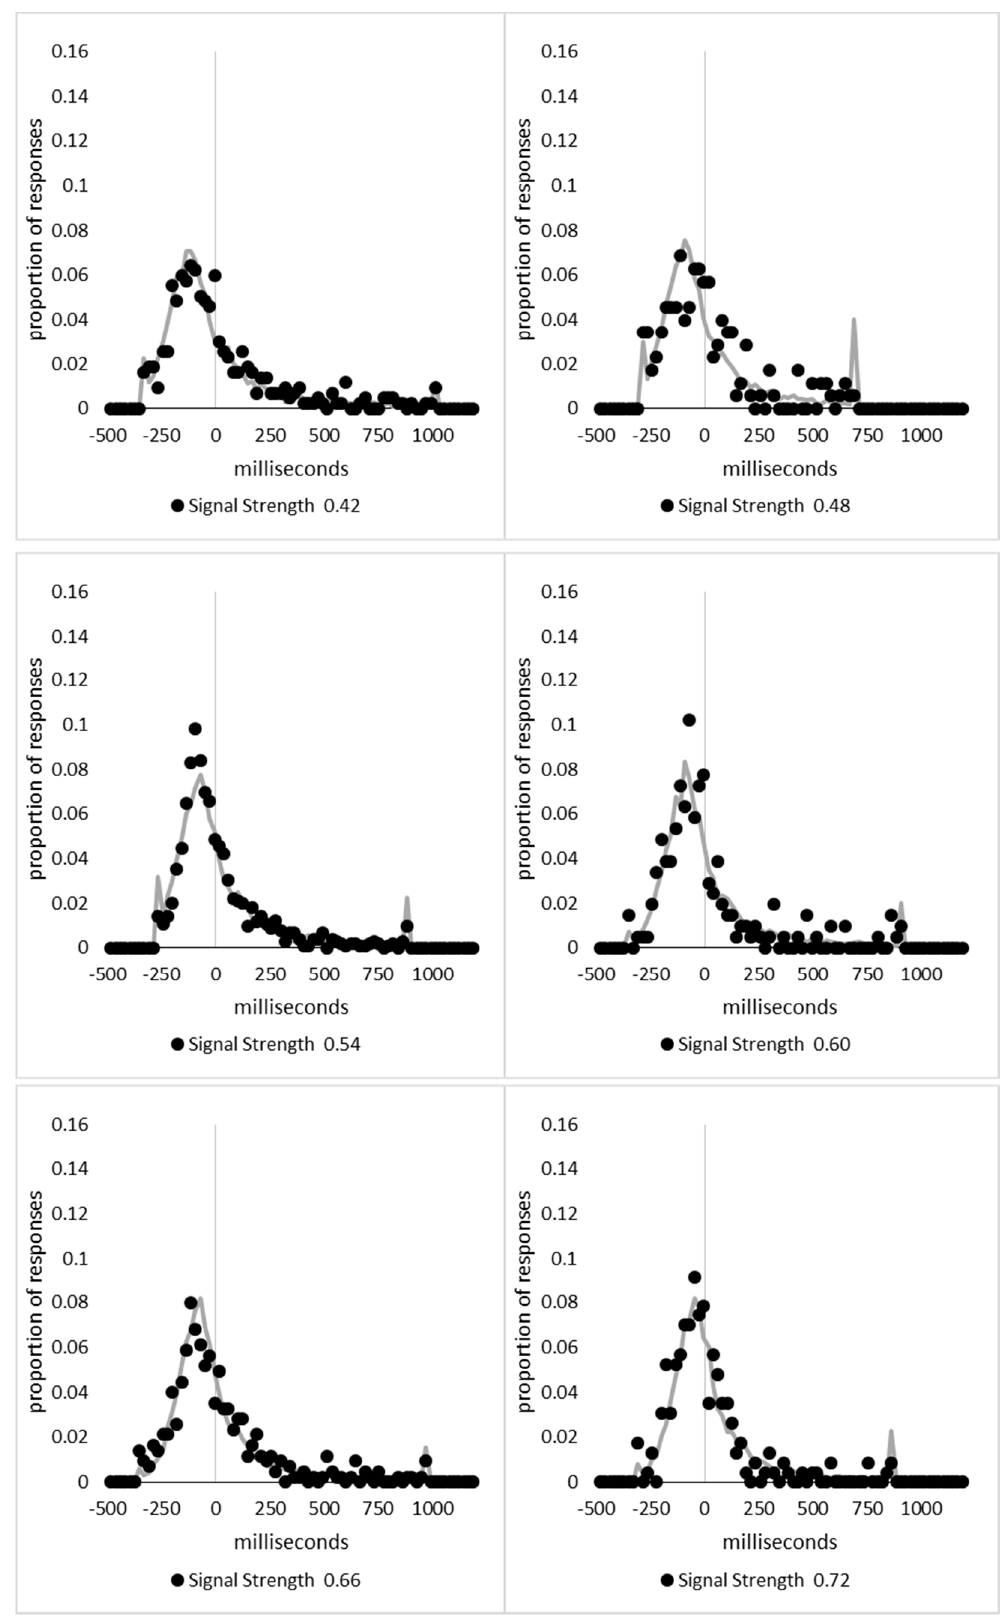
Figure A2. Density functions of the observed data (filled circles) and model (solid line) for signal strength bins 0.42 to 0.72.